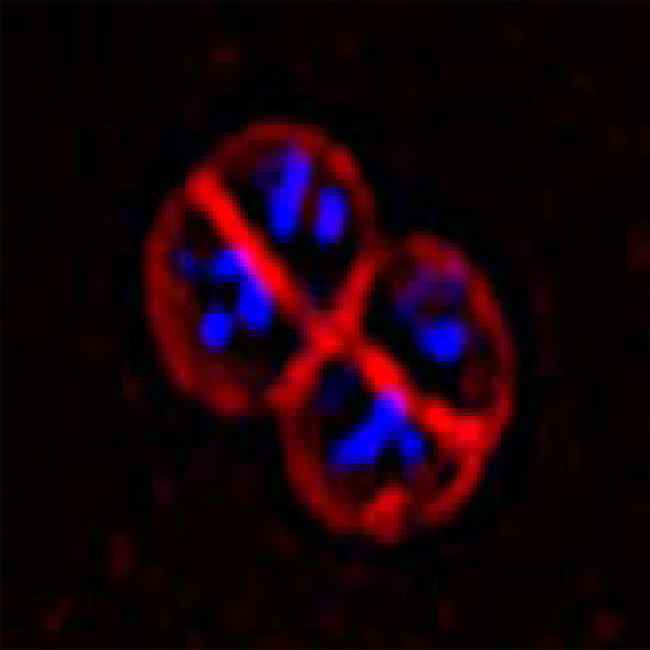

D. radiodurans R1